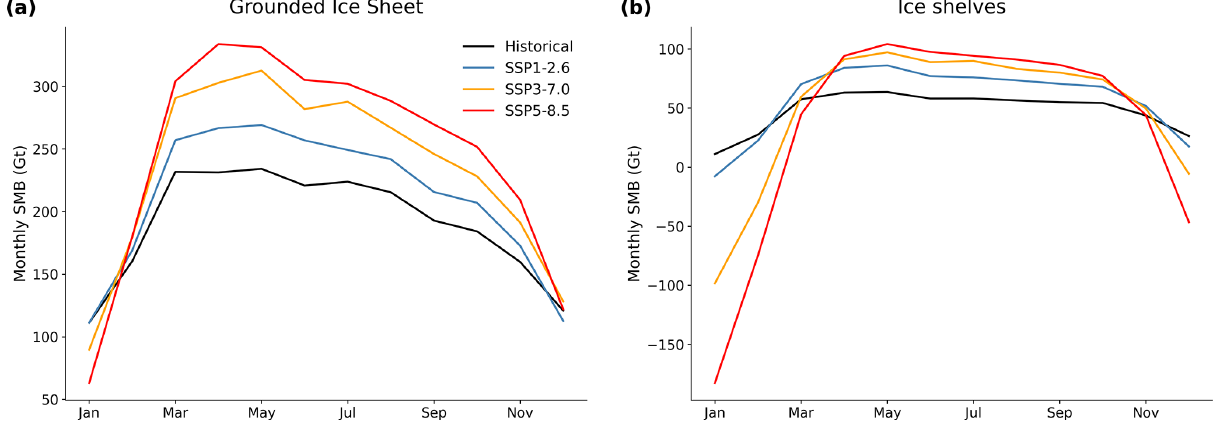
Figure 9. Seasonality of SMB in the last decade of historical (2005–2015) and future (2090–2100) SSP model output over the (a) grounded ice sheet and (b) ice